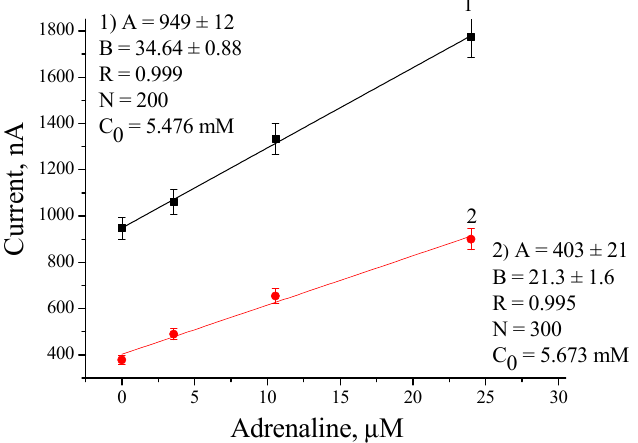
Figure 7. Determination of AD concentration in the sample of the pharmaceutical “Adrenaline (Epinephrine)” solution (for injection in the ampoule) using the nAuCePt-based chemosensor with the SAT method.